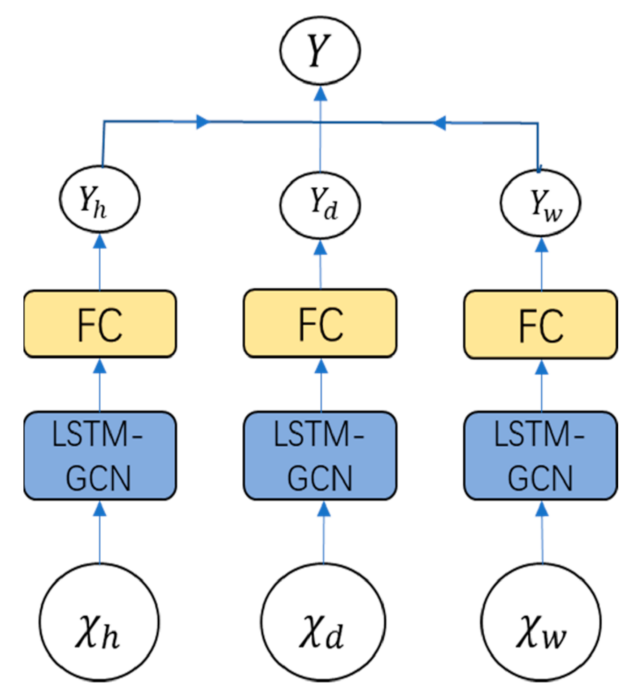
Figure 3. LST-GCN model frame